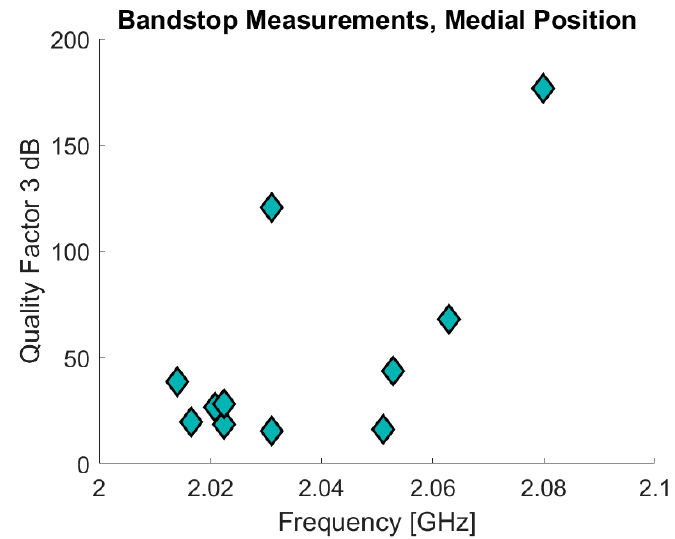
Figure 17. Bandstop and SRR volunteer measurements.